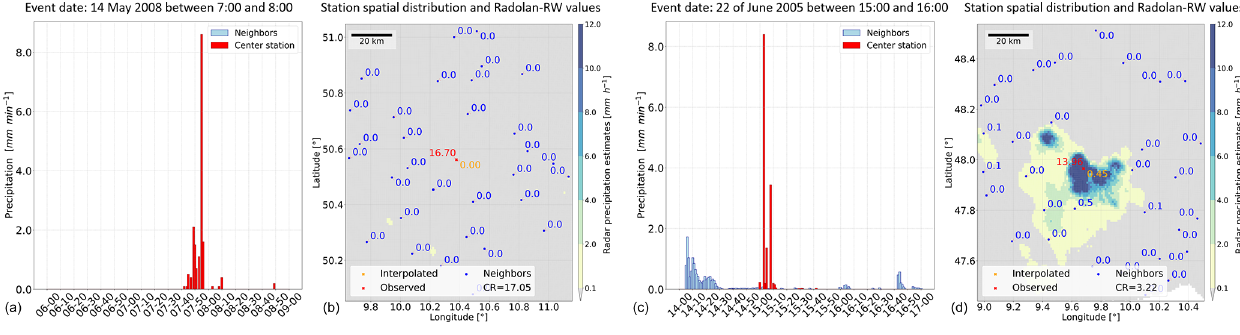
Figure 4. Two examples are shown, i.e., (a) an identified false observation and (c) a plausible event. Panels (b) and (d) show the values at the neighboring stations (in blue), the observed value (in red), the estimated value (in orange), and the RADOLAN-RW QPE data for that